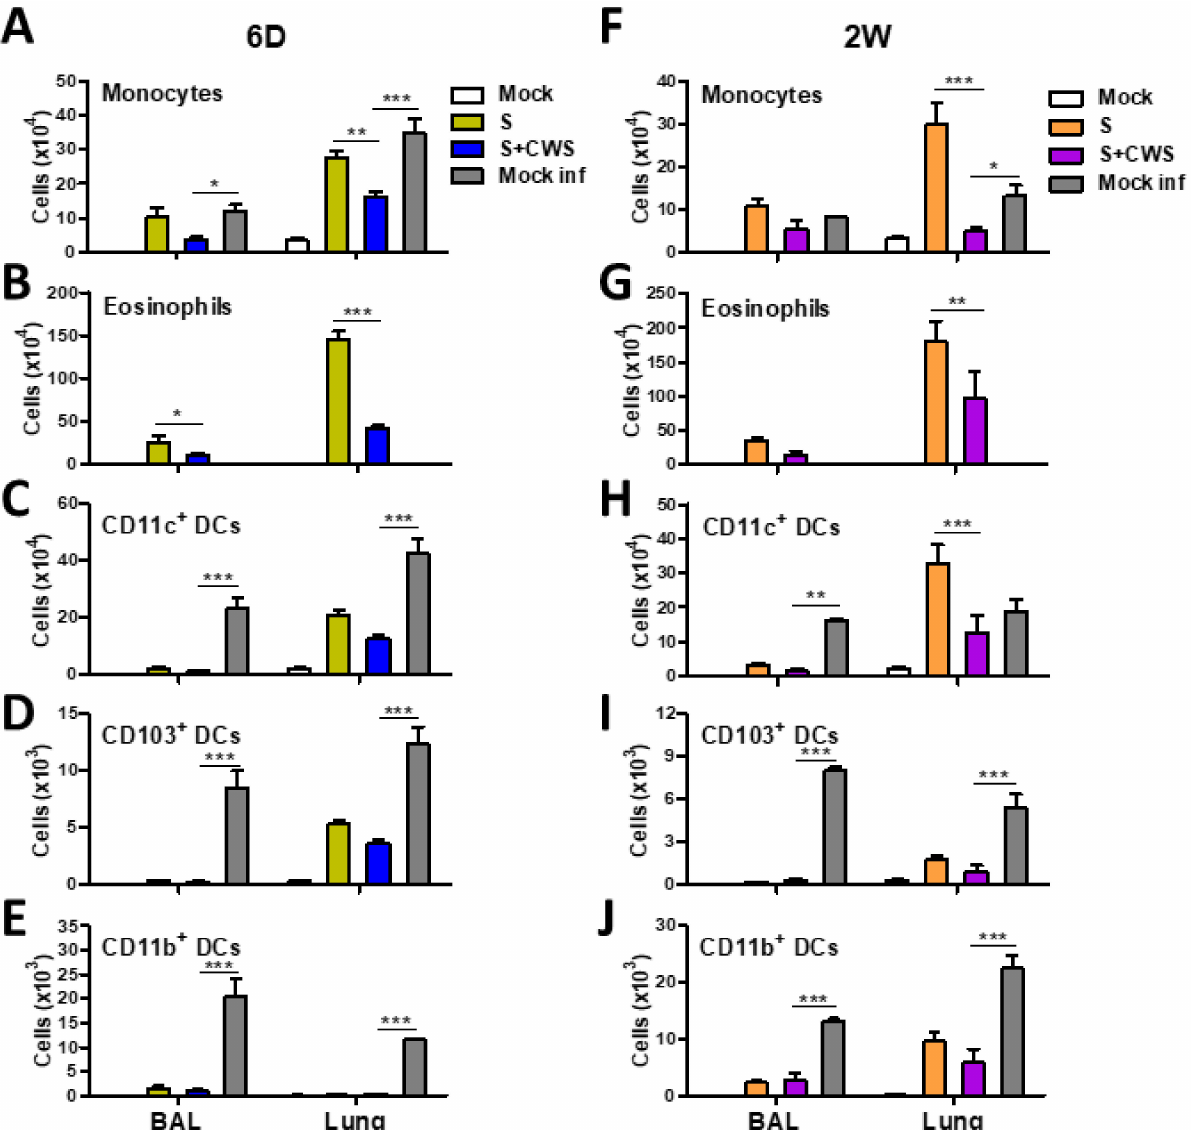
Figure 4. BCG-CWS-adjuvanted 6 D and 2 W mice protect against excessive cellular infiltration into the lung after challenge . Cellular phenotypes were determined by flow cytometry in BAL and lung samples collected at 7 dpi with A/Cal virus. ( A , F ) Monocytes ( + CD11b + Ly6c hi F4/80 + ) and ( B , G ) Eosinophils ( + CD11b + CD11c - SiglecF + ) were gated from CD11b + cells. CD11c + dendritic cells (DCs, CD45 + F4/80 - CD11c + MHCII hi ), CD103 + DCs (CD45 + F4/80 - CD11c + MHCII hi CD11b - CD103 + ), and CD11b + DCs (CD45 + F4/80 - CD11c + MHCII hi CD11b + CD103 - ) were gated from CD45 + F4/8 - cells ( C , H ) and CD45 + F4/80 - CD11c + MHCII hi cells ( D – J ), respectively, in BAL and Lung of 6 D and 2 W age mice ( n = 10 each age mice). The low cell numbers of eosinophils were observed to be 1030 and 3292 in the BAL and lungs from mock infected mice. Statistical significance was calculated by using two-way ANOVA and a Bonferroni’s multiple-comparison test. Error bars indicate the mean ± SEM. *; p < 0.05, **; p < 0.01, ***; p <